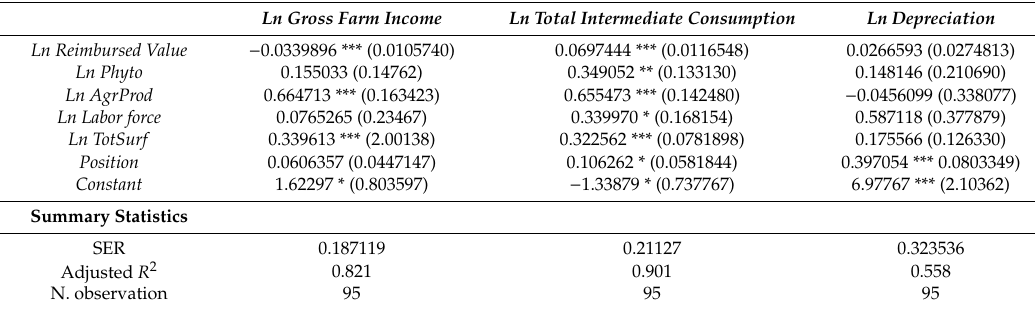
Table 4. Regression